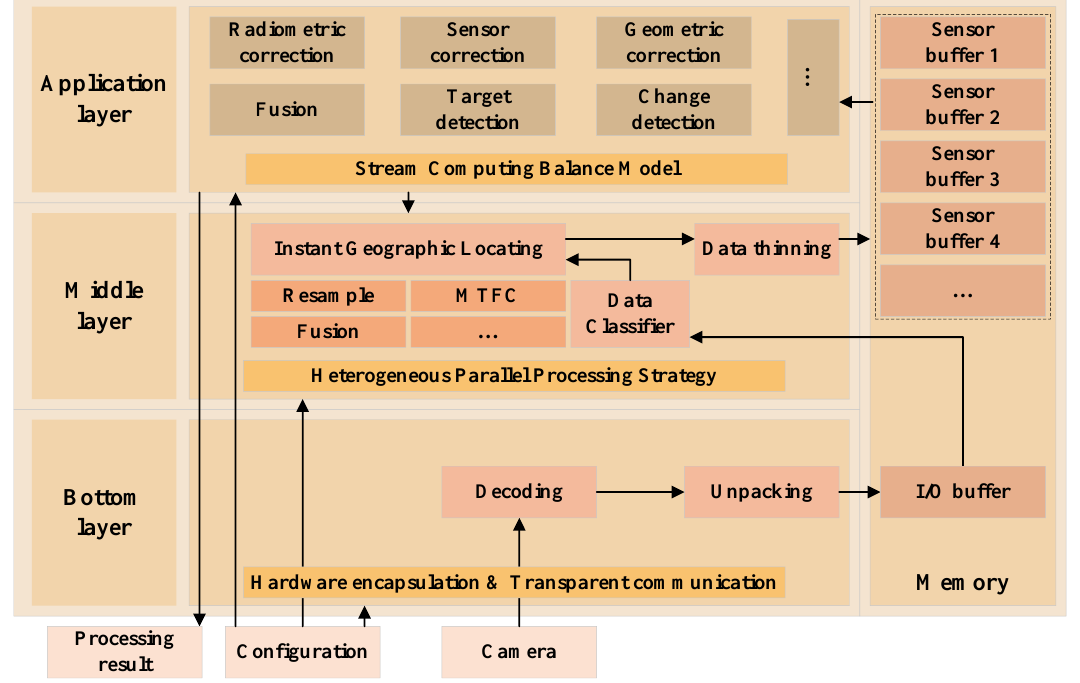
Figure 4. Multilayer structure of the edge computing architecture.